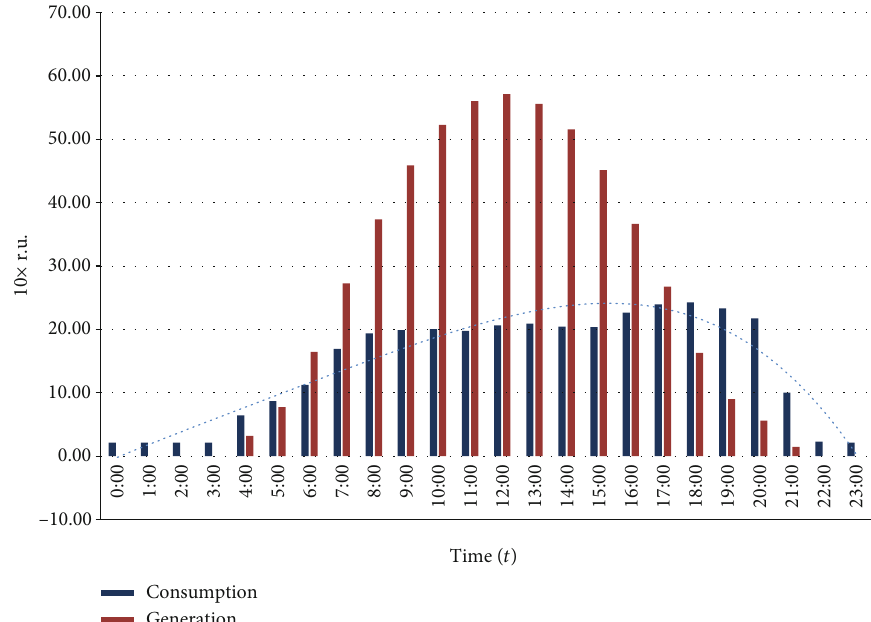
Figure 11: Consumption and average square value of power generated in summer months.